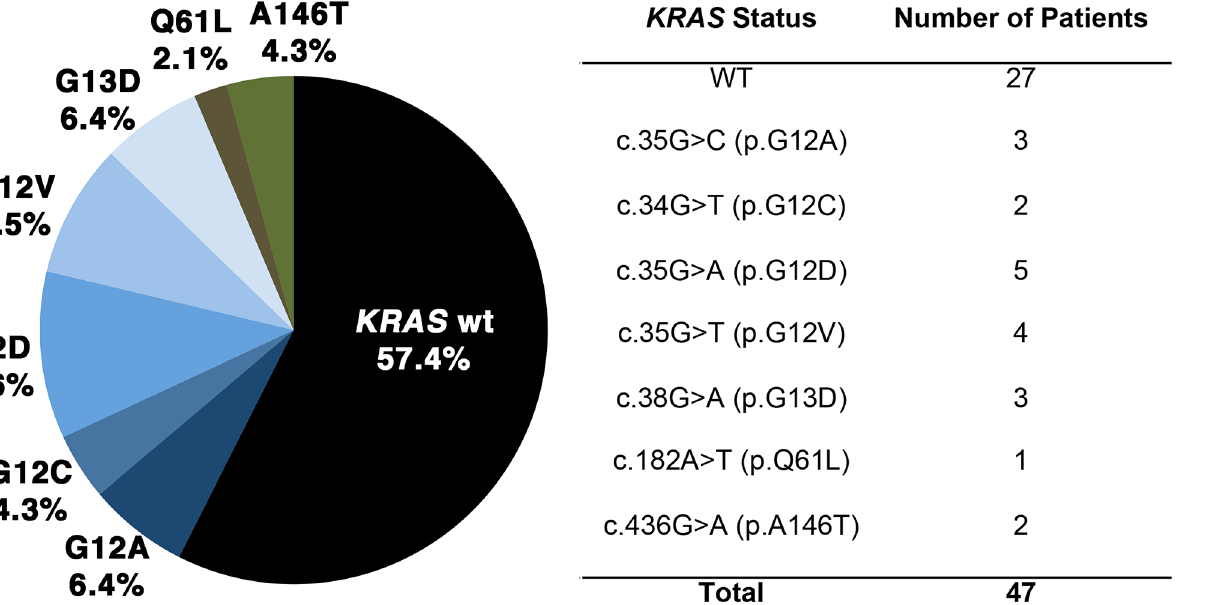
PLOS ONE | DOI:10.1371/journal.pone.0153278 April 11,